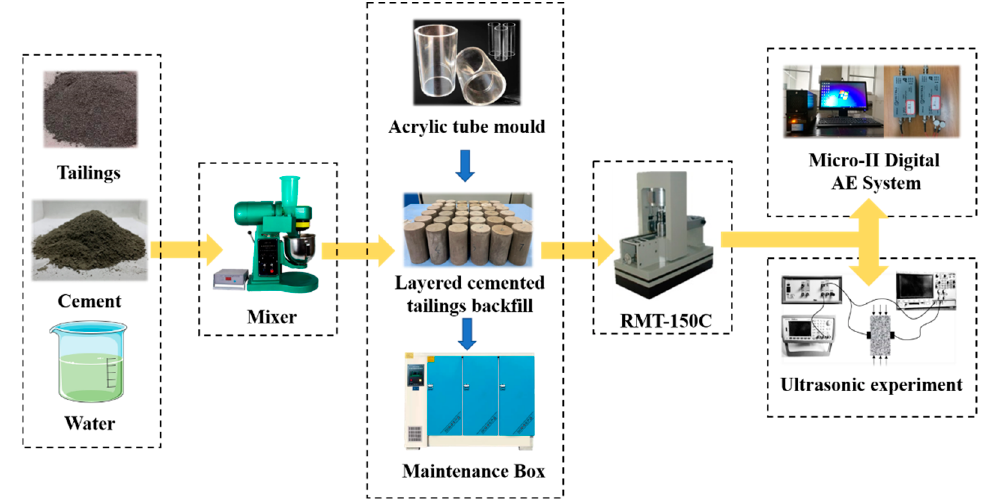
Table 2. Equipment information for ultrasound systems.